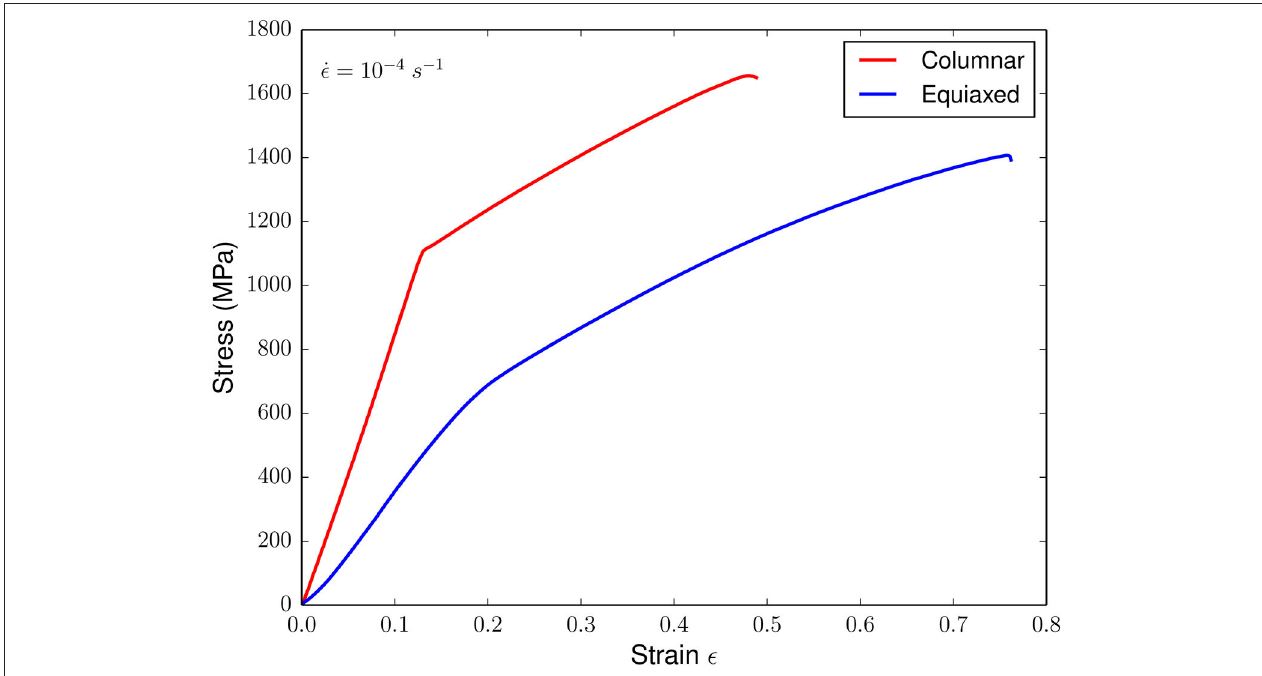
FIGURE 2 | Typical strain-stress curves obtained for the columnar and equiaxed structures. For columnar samples, the loading direction is parallel to the growth direction.